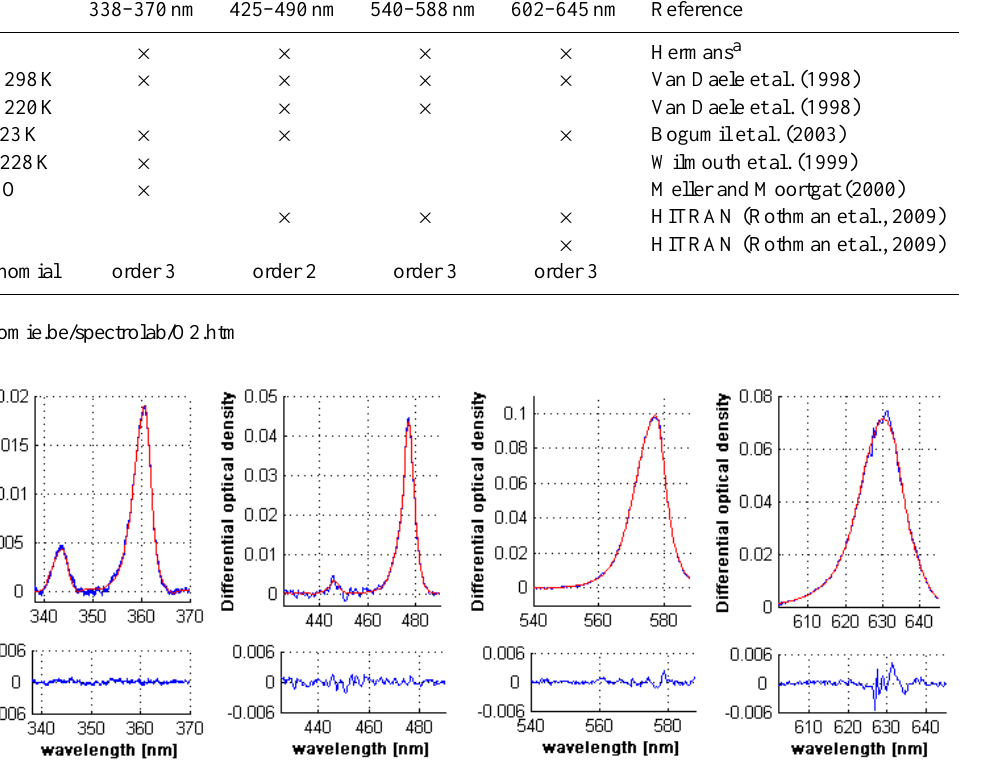
Fig. 2. Example of an O 4 fit in four wavelength intervals used in this study, as recorded in Beijing on 15 November 2008 at 06:15:00UTC. The O 4 DSCDs and DOAS fit errors are (4.46 ± 0.013), (6.75 ± 0.023), (9.03 ± 0.021), (10.1 ± 0.14) × 10 43 molec 2 /cm 5 for the wavelength intervals centered around 360, 477, 577, and 630nm,